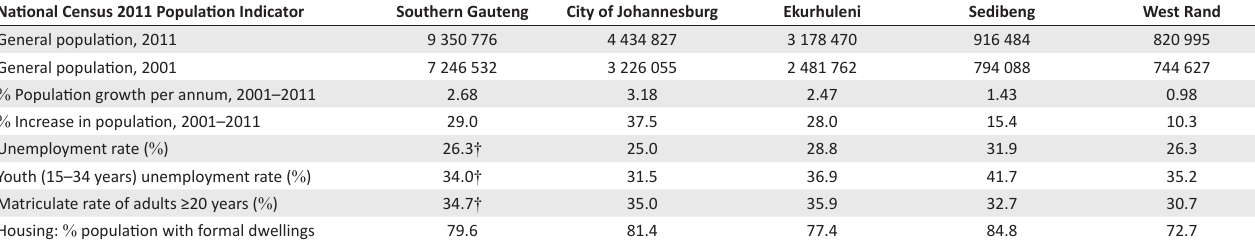
TABLE 1: District population indicators, according to the National Census, 2011. National Census 2011 Population Indicator Southern Gauteng City of Johannesburg General population,